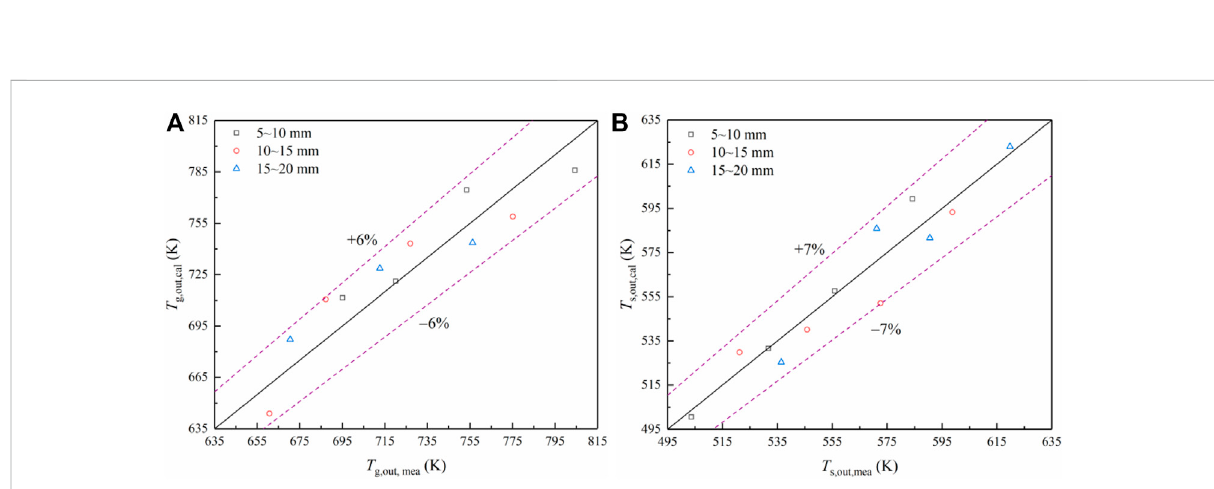
FIGURE 4 (A) Comparison between predicted values T g , out , cal and measured values T g , out , mea of the gas outlet temperature; (B) Comparison between predicted values T s , out , cal and measured values T s , out , mea of the sinter outlet temperature.